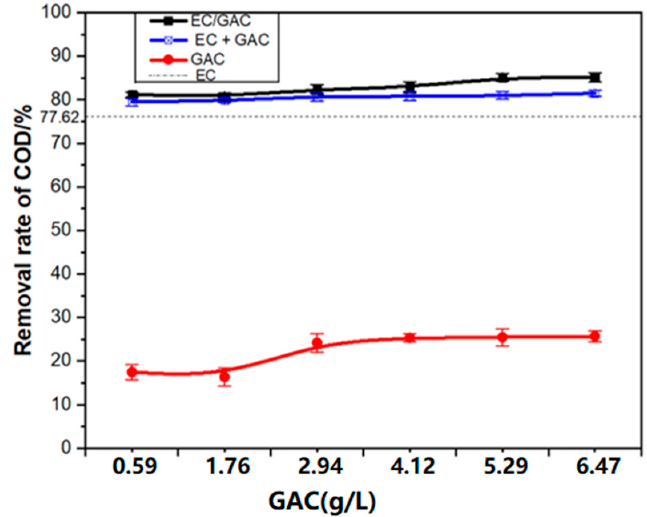
Figure 8. Effect of granular activated carbon (GAC) treatment on mixed wastewater COD removal rate (anode material: Fe, cathode material: Stainless steel, current density: 19.27 mA/cm 2 , pH: 7.1, electrolysis time: 70 min).